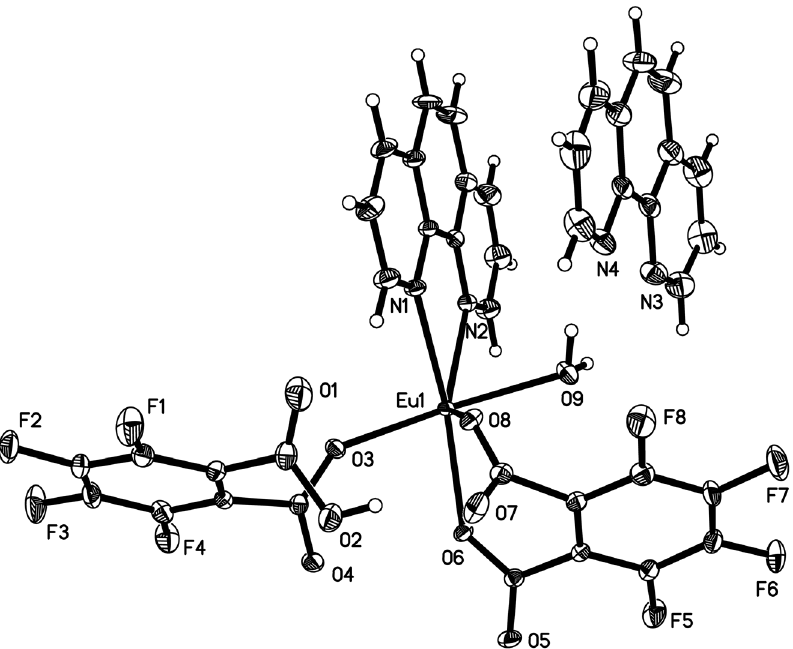
Table  : Data collection and handling.